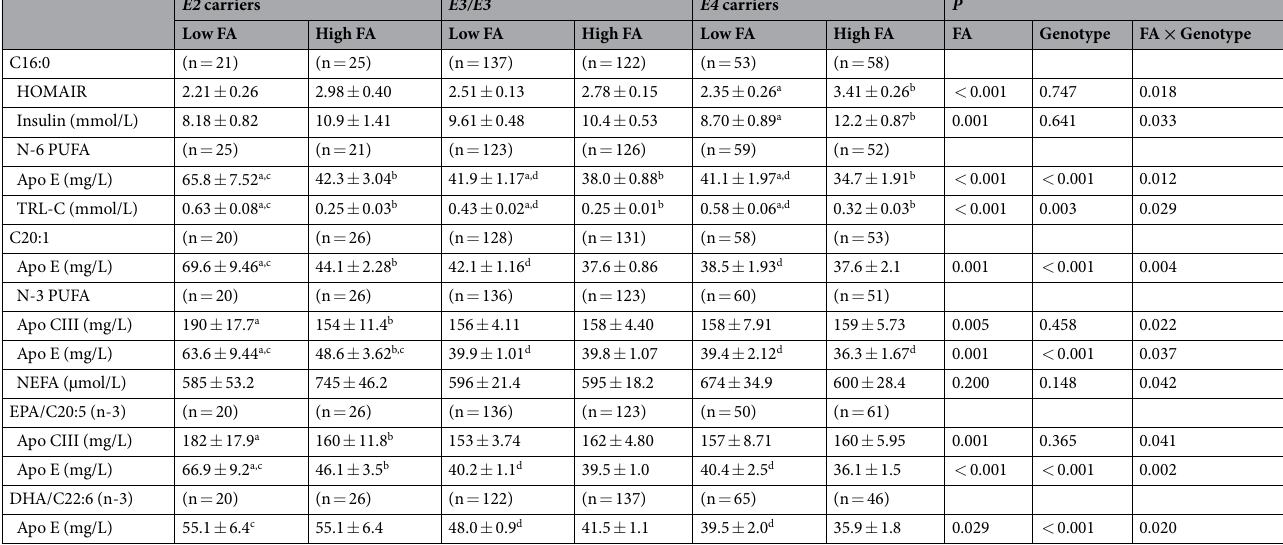
Table 3. Significant associations and interactions for baseline plasma FA (%FA) and APOE genotype on metabolic variables in the LIPGENE Dietary Fatty Acid Intervention Study (n = 416). Abbreviations: DHA, docosahexanoic acid; EPA, eicosapentanoic acid; FA, fatty acid; HOMA-IR, homeostasis model assessment of insulin resistance; NEFA, non-esterified fatty acid; PUFA, polyunsaturated fatty acid TRL-C, triglyceride rich